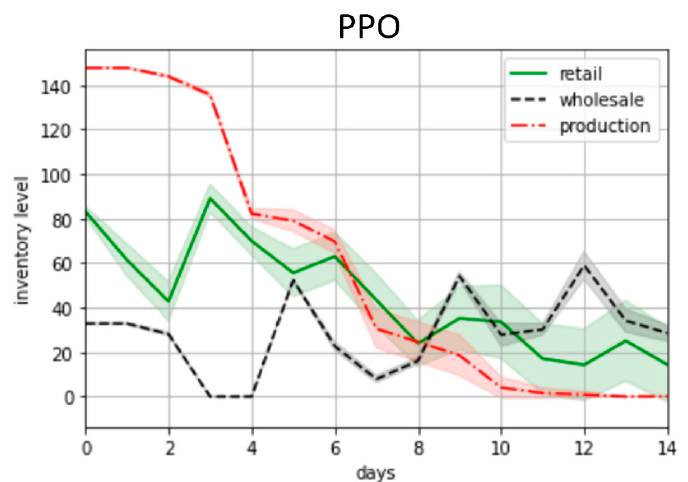
Figure 4. Inventory dynamics under the control of the trained PPO agent during the first experi- ment.